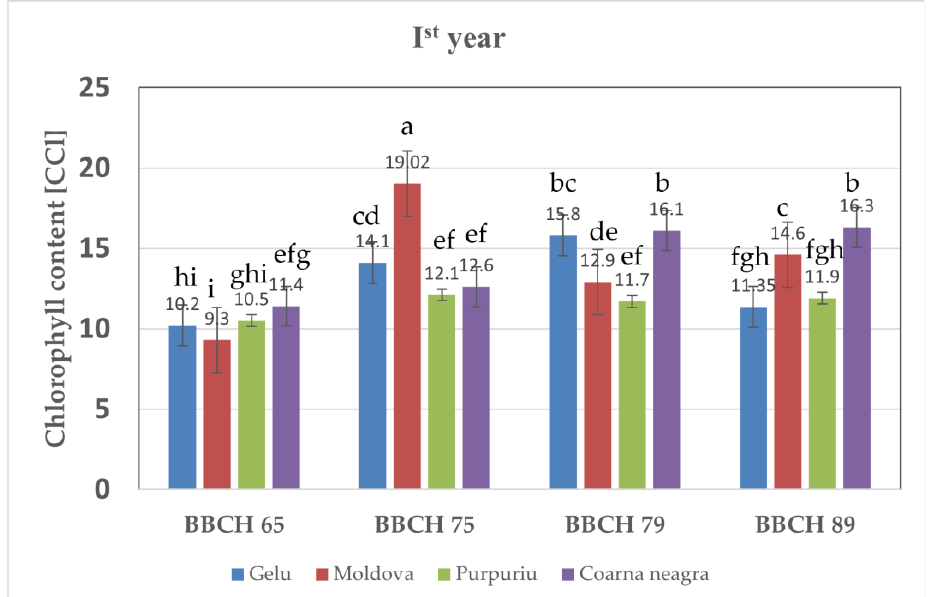
Figure 2. Dynamic evolution of the chlorophyll content (in CCl units) in the leaves of the four studied grapevine varieties in the first year with significant differences at 0.05 level indicated with letters. (BBCH65 — full flowering: 50% of flower-hoods fallen; BBCH75 — berries pea-sized, bunches hang; BBCH79 — majority of berries touching; BBCH89 — berries ripe for harvest).